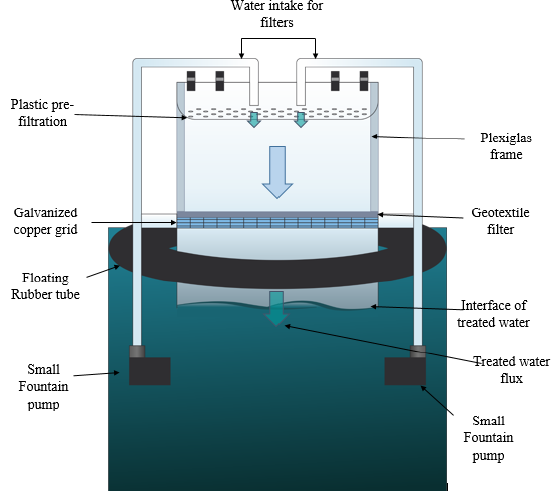
Figure 2. Floating filtration unit components.